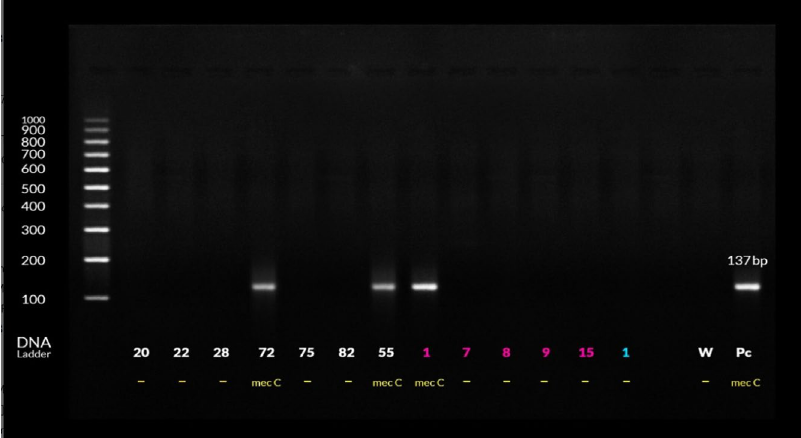
Fig. 2. Gel electrophoresis of mecC gene amplification shows mecC bands at